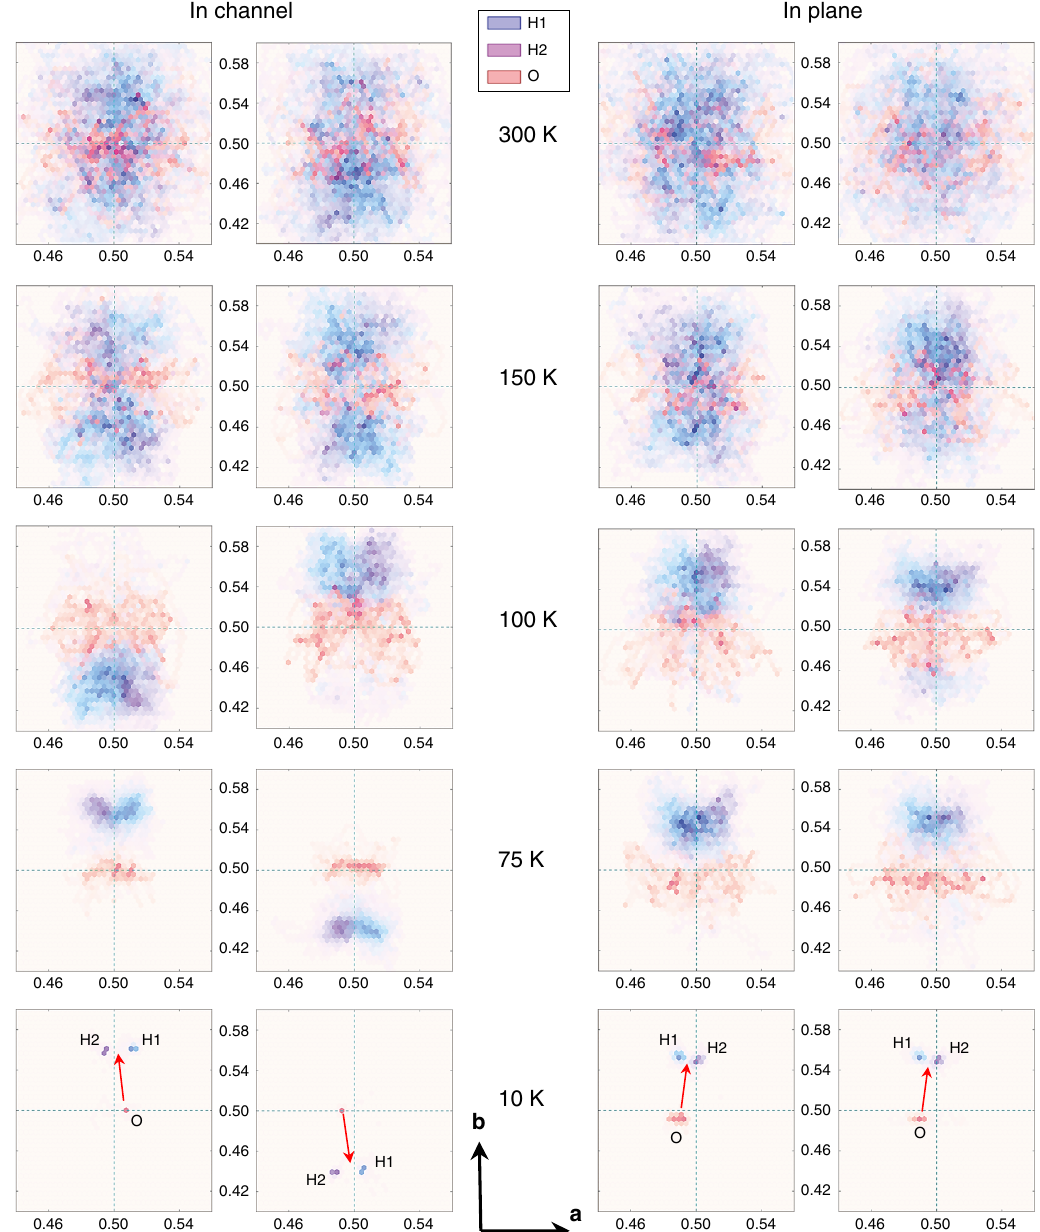
Fig. 5 Temperature-dependent dynamics of nanocon fi ned water molecules. Density functional theory molecular dynamics simulation during 15 ps and at fi ve temperatures of two water molecules within two nanocages of cordierite crystal lattice, located next to each other along the channel c -axis (left) and within the ab -plane (right). The panels display projections of oxygen ions (O) and two protons (H1, H2) of the H 2 O molecules on the ab -plane; the c -axis is perpendicular to the fi gure plane. Red arrows represent the dipole moments of the molecules that show antiferroelectric alignment for molecules located along the channel and ferroelectric alignment for molecules in the ab -plane. Numbers correspond to the coordinates of atoms within the cages in fractions of translation vectors of cordierite unit